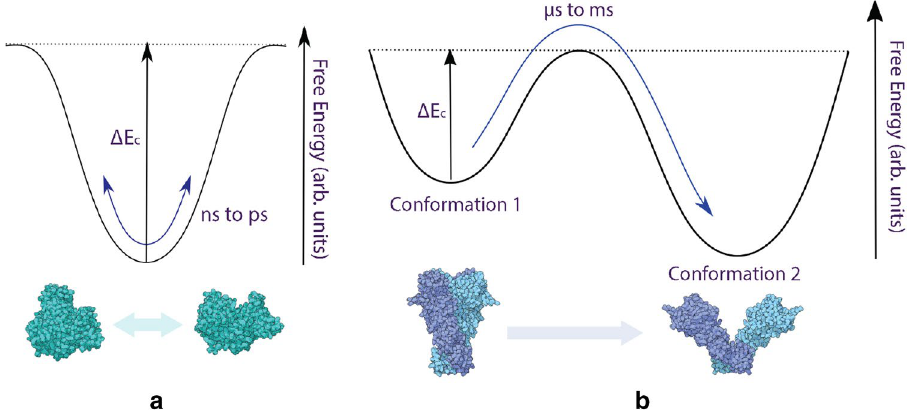
Figure 5. ( a ) Fluctuations in polarizability on a picosecond-nanosecond time scale are typically due to thermal fluctuations of a single molecular conformation 46 , [PDBID: 3V03] 40 , illustrative purposes only. ( b ) Free energy diagram of a conformational change of a molecule, which typically occurs over a time scale of microseconds to milliseconds 46 , [PDBID: 2CG9, 2IOQ], illustrative purposes only.